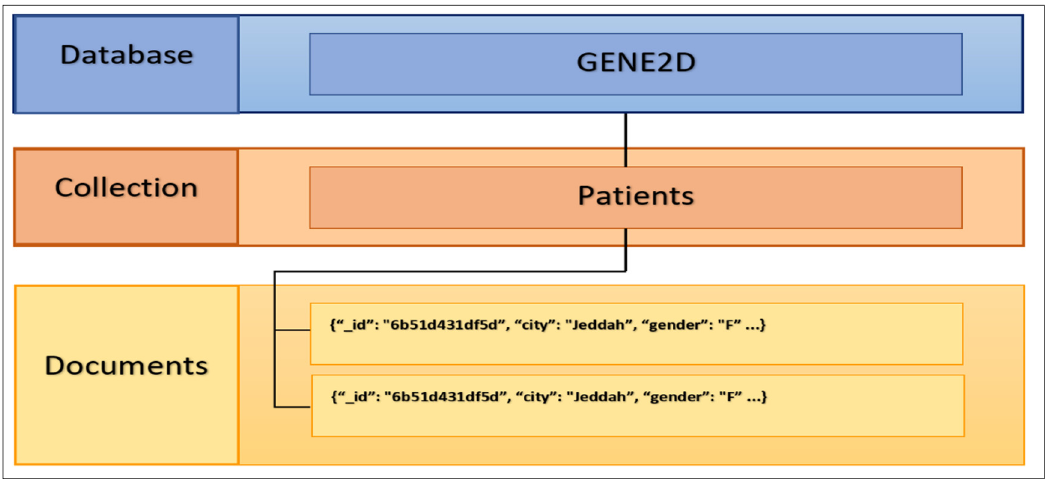
Figure 3. The GENE2D database structure.